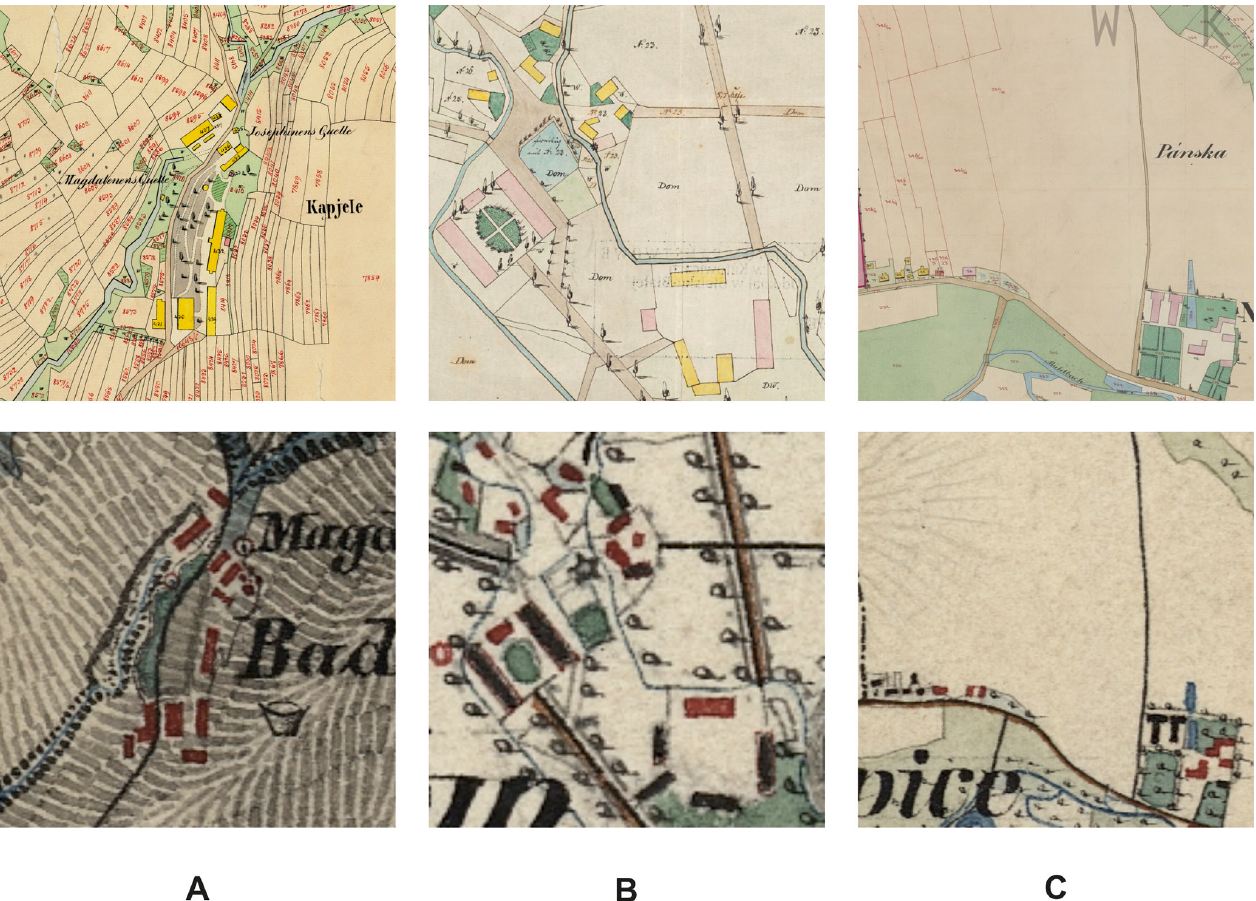
Figure 2. Comparison of cadastral 1 : 2880 maps (upper row) and Second Military Survey 1 : 28800 maps (lower row) for Szczawnica (a) , Kaniów (b) , and Niewiarów (c) in Galicia (source: National Archive in Kraków, National Archive in Katowice, Austrian State